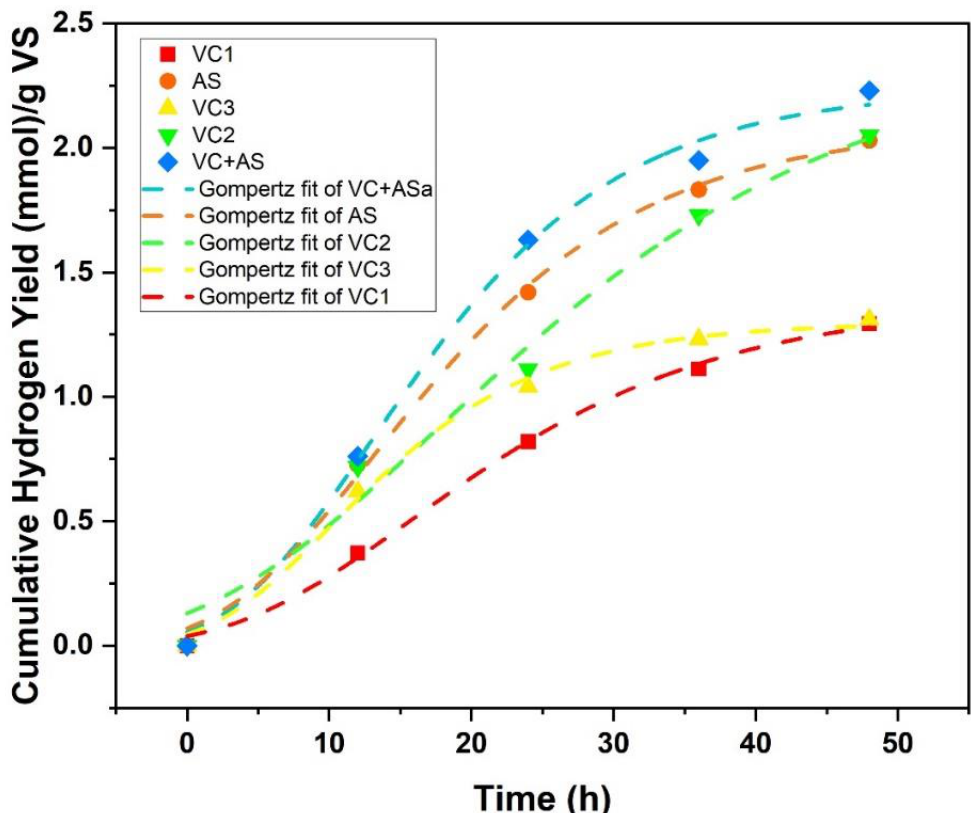
Figure 10. Gompertz model for biohydrogen production.